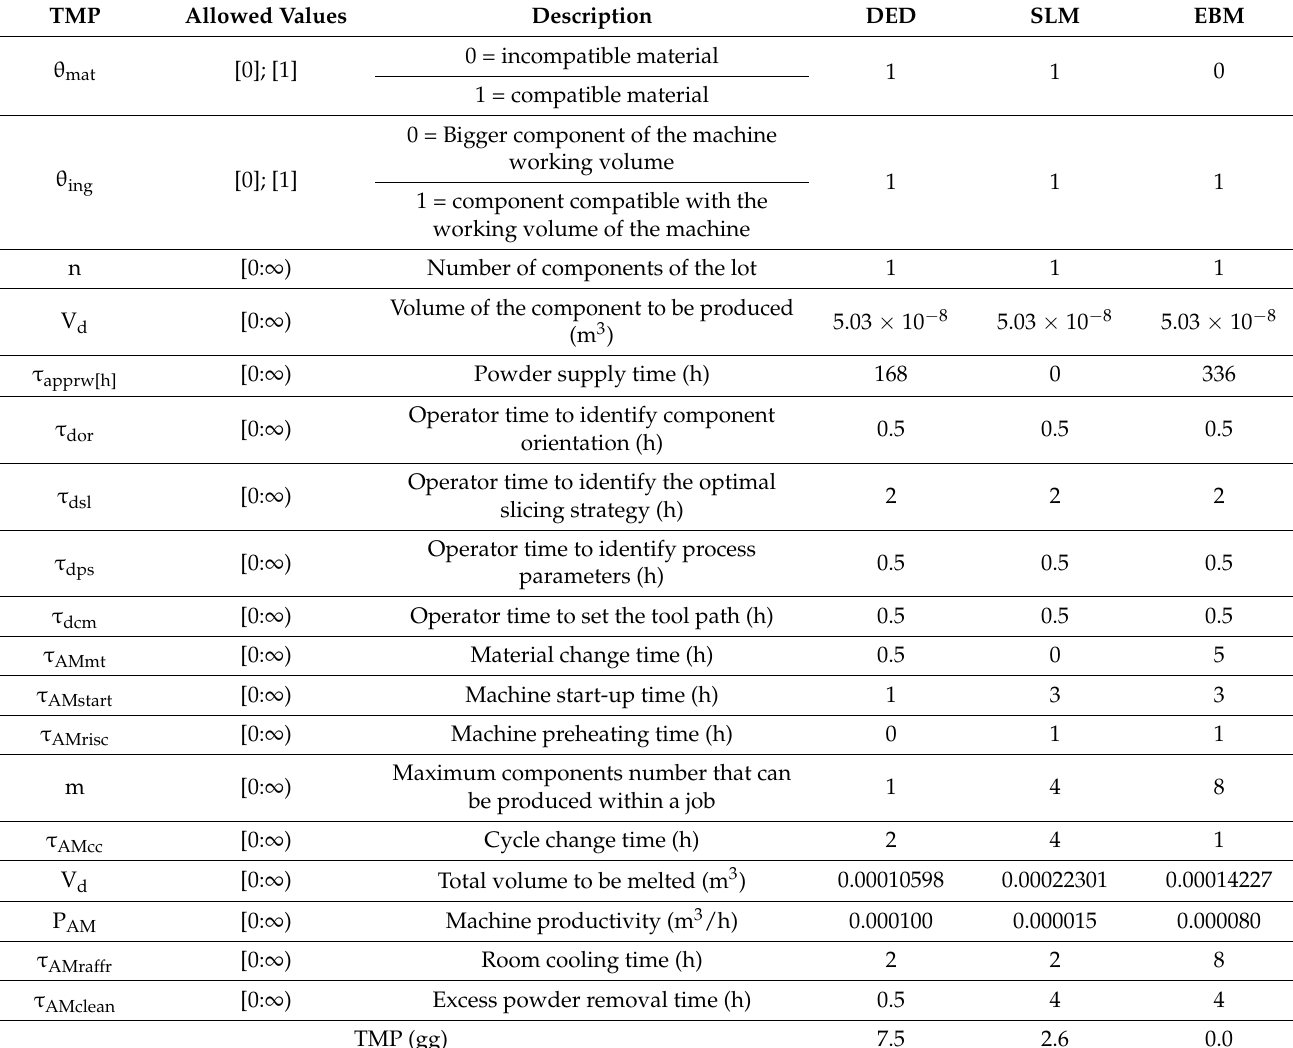
Table 9. TMP calculation for the FDM head for traditional